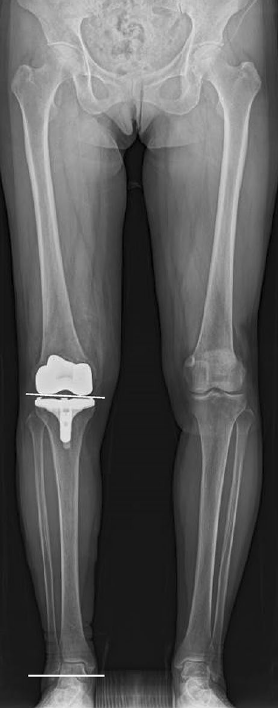
Figure 2. Joint line orientation angle (JLOA). The JLOA is the angle between the joint line and a line parallel to the floor, and medial inclination (medial side down and lateral side up) was defined as